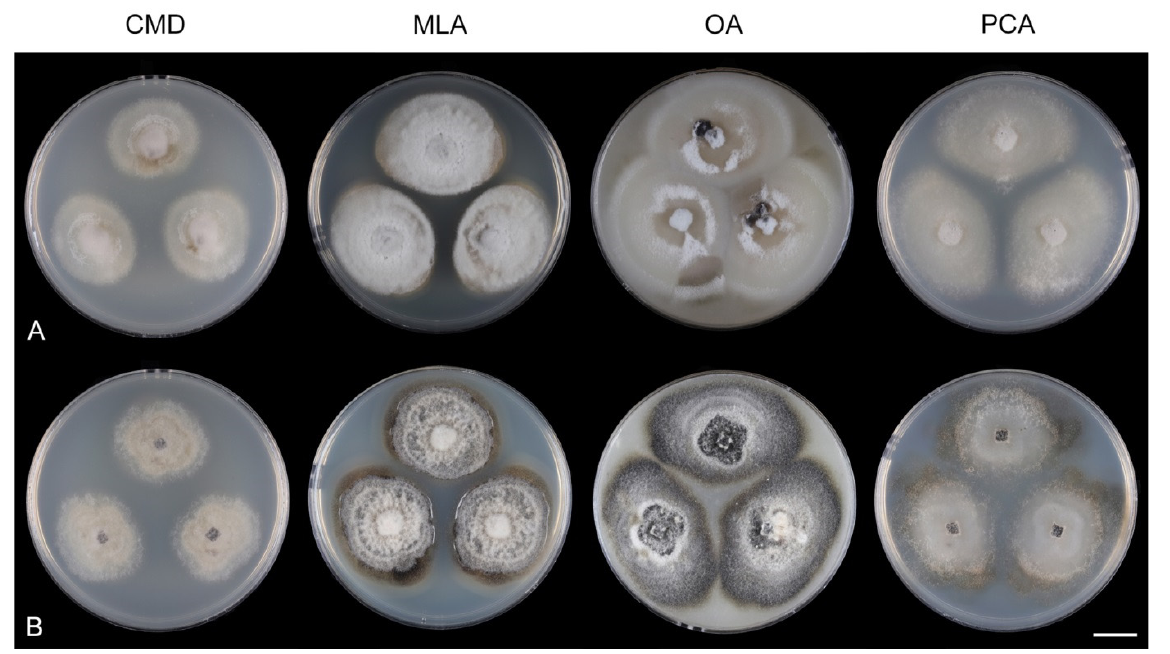
Figure 40. Colony morphology of Stilbochaeta novae-guineensis after 4 weeks. ( A ) CBS 147515 ( B ) CBS 147517. Scale bar: ( A , B ) 1 cm.